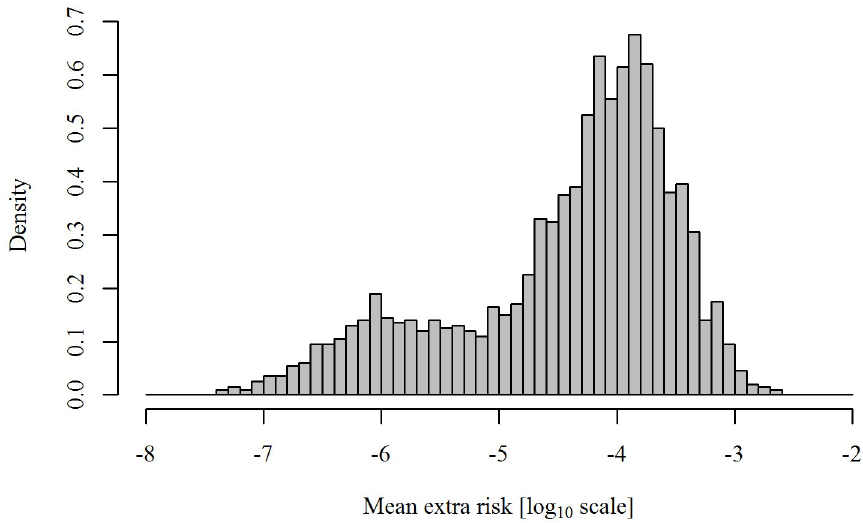
Fig 6. Uncertainty distribution of the mean extra lifetime risk of cancer due to exposure to benzo[ a ]pyrene from barbecued meat in the Danish population on the log 10 scale. The distribution represents the uncertainty of the mean extra lifetime risk in the Danish population. Each value of the mean extra lifetime risk (2,000 uncertainty iterations) is the average of the 10,000 individuals (variability) for a fixed setting of the uncertainty.